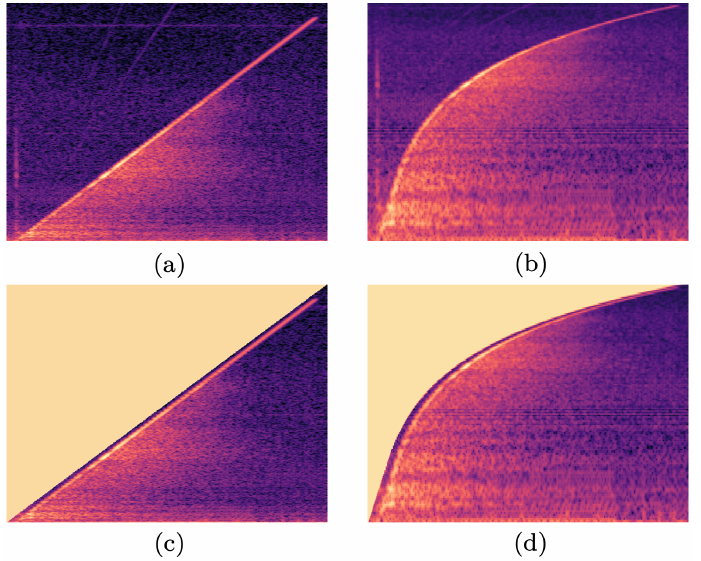
Figure 4. A response of object (j) shown in the four data types used to train the various CNNs; ( a ) spectrogram, ( b ) mel-spectrogram, ( c ) cropped spectrogram and ( d ) cropped mel-spectrogram. Axes are not presented to the CNN; similarly, the colours represent normalised amplitude.